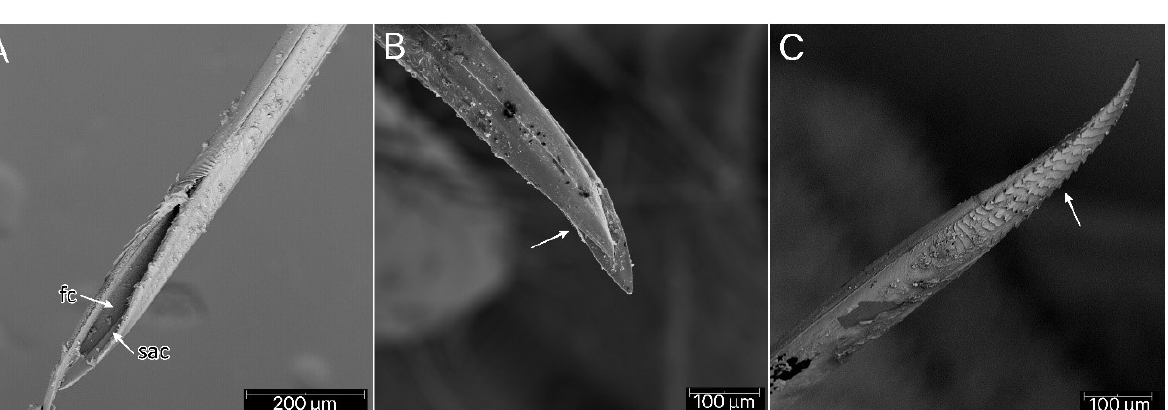
Figure 21. Psyttala horrida (Stål, 1865) third instar, SEM views. ( A ) Fourth visible labial segment with sensilla chaetica and trichodea ; ( B ) sensory field at the tip of the labium; ( C ) sensilla coeloconica on the distal part of the labium, right under the sensory field; ( D ) magnification of the single sensillum coeloconicum . ch1 — sensillum chaeticum type 1; ch2 — sensillum chaeticum type 2; inf-soc —inflexible socket; pps —porus peg sensillum; sc — sensillum coeloconicum ; ts — sensillum trichodeum .